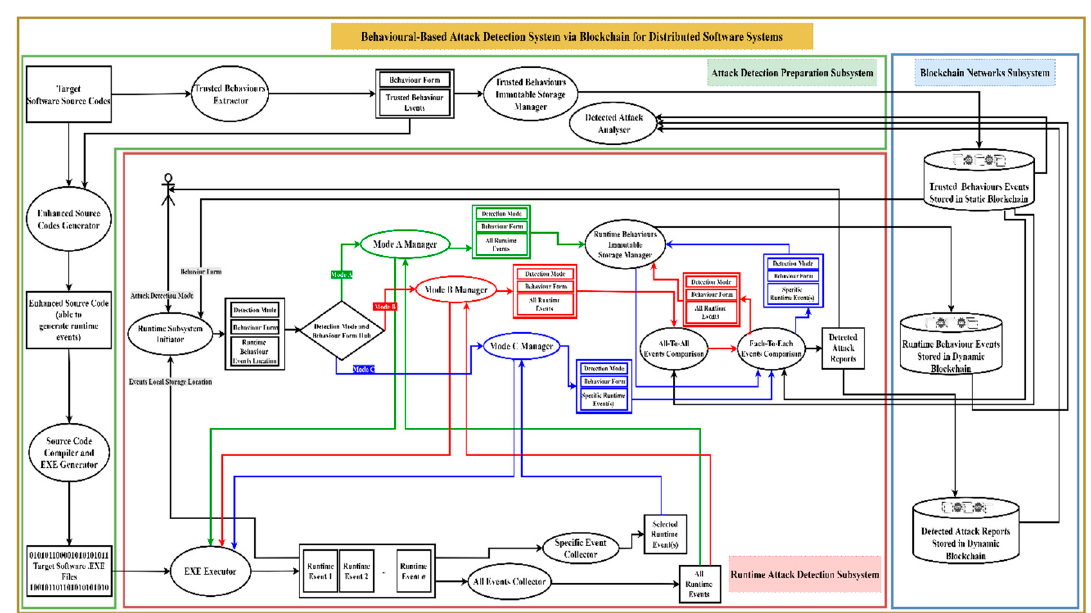
Figure 7. The proposal software system architecture.